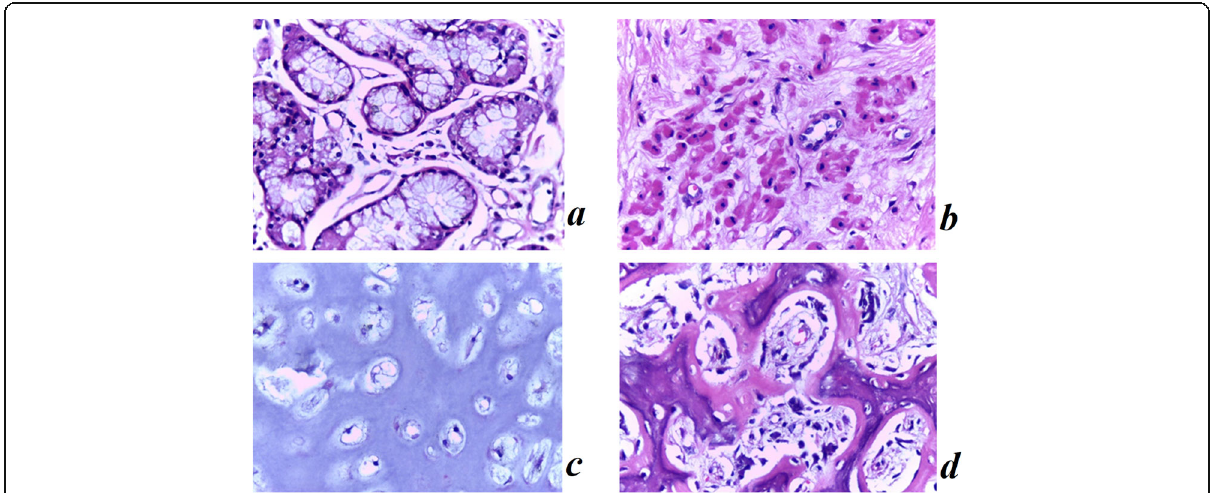
Fig. 6 a × 40 H&E slide of glandular epithelium with goblet cells. b × 40 H&E slide skeletal muscles. c × 40 H&E slide of mature cartilage. d × 40 H&E slide of